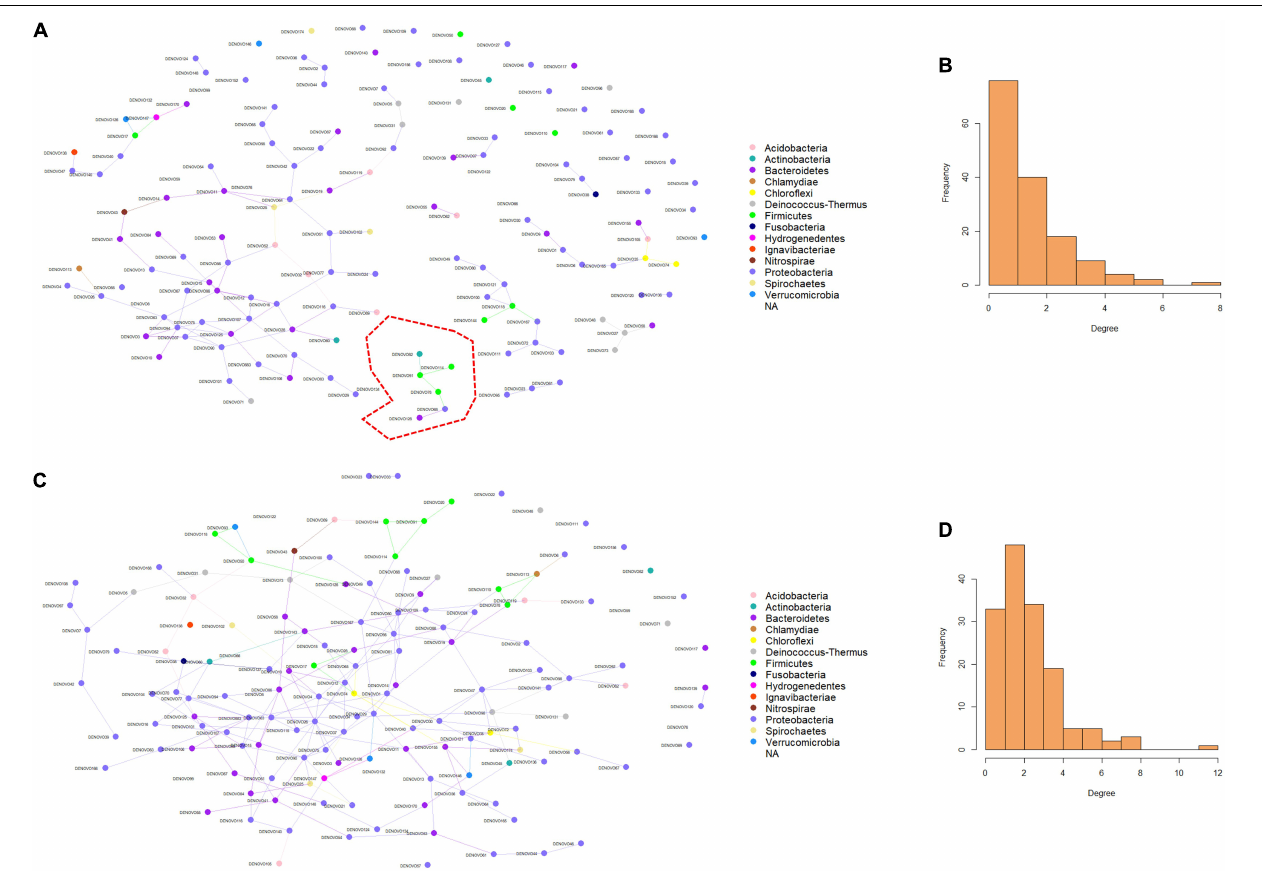
FIGURE 5 | Predicted association of bacteria in the buccal cavity of female and male Nile tilapia. Network of bacteria in the female (A) and male (C) buccal cavity was constructed using the SpiecEasi package. Each node represents a taxon (ASV) and connections between nodes are shown using edges. The degree distribution in the network of bacteria of the female (B) and male (D) buccal cavity indicates the high node degree in the males (D) . The cluster in red is detailed in Figure 6